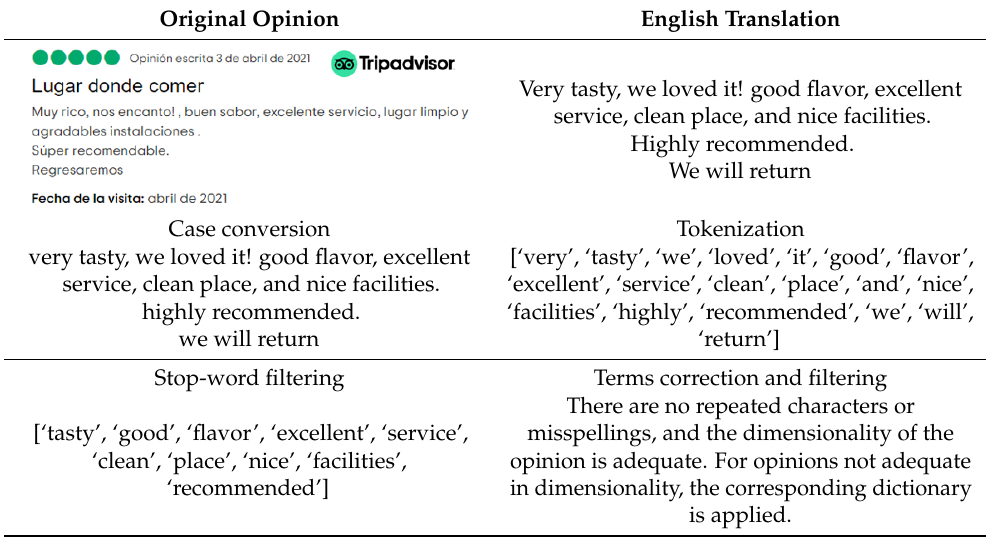
Table 2. Pre-processing steps of a real opinion.